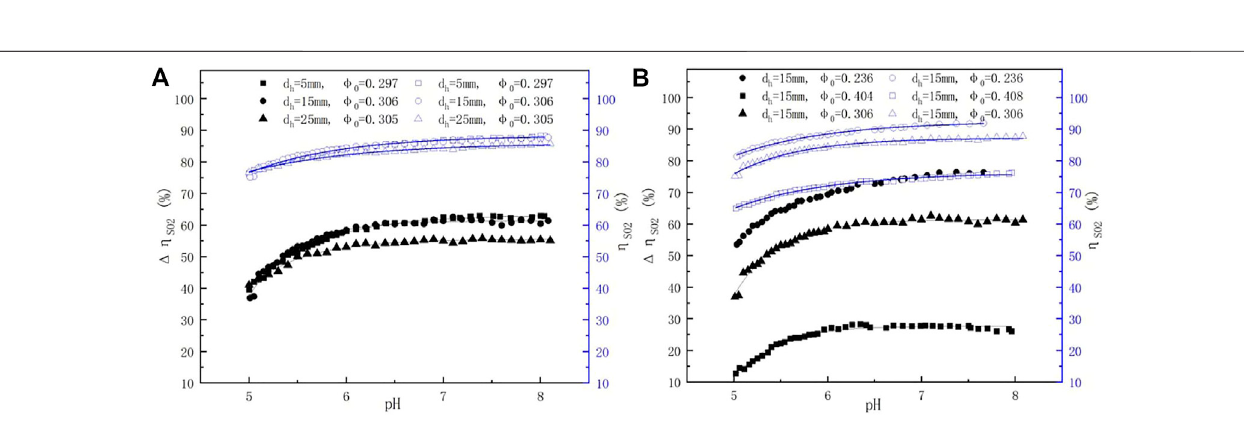
FIGURE 9 | Δη SO2 and η SO2 under different pH values (V L = 1.6 m 3 /h, V G = 95 m 3 /h, and C SO2 = 750 ± 100 mg/m 3 ), (A) pore diameter, and (B) porosity.